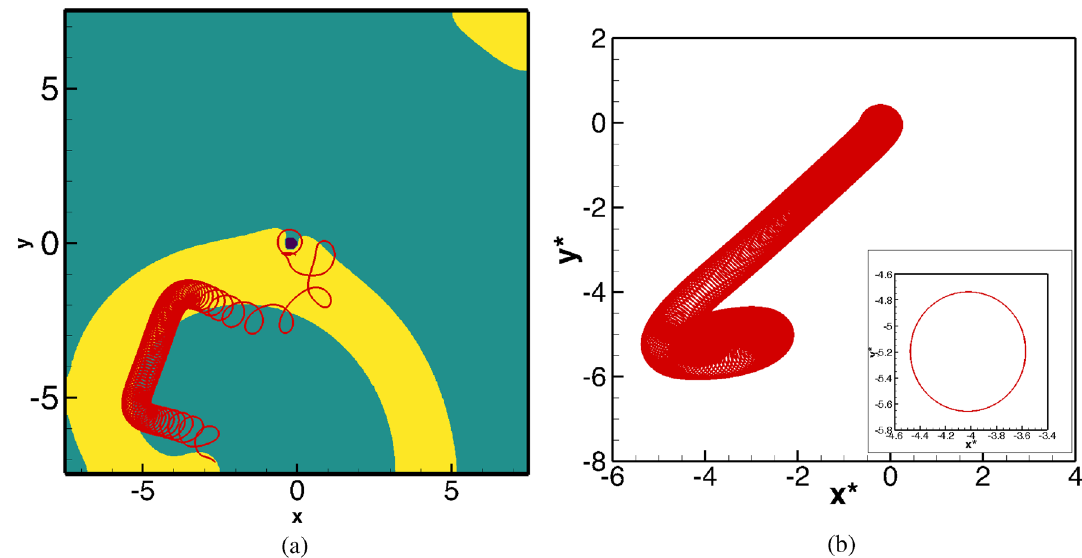
Figure 12. Dynamics for γ = − 0.01 : ( a ) tip path with the obstacle for 100 ≤ t ≤ 216.11 along with pattern at 216.10, ( b ) tip paths without the obstacle for 100 ≤ t ≤ 1500 with the final periodic pattern at the inset for 1200 ≤ t ≤ 1300 .